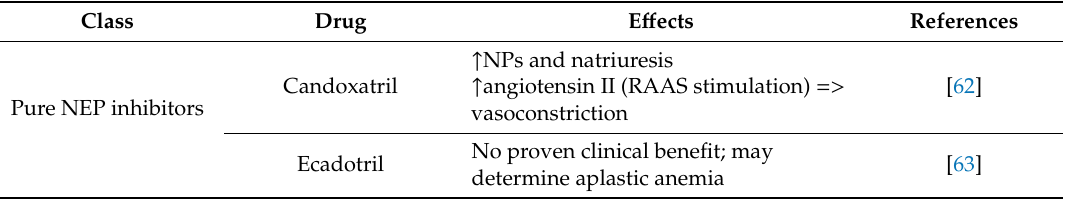
Table 4. Dual and triple endothelin converting enzyme, neutral endopeptidase and angiotensin converting enzyme